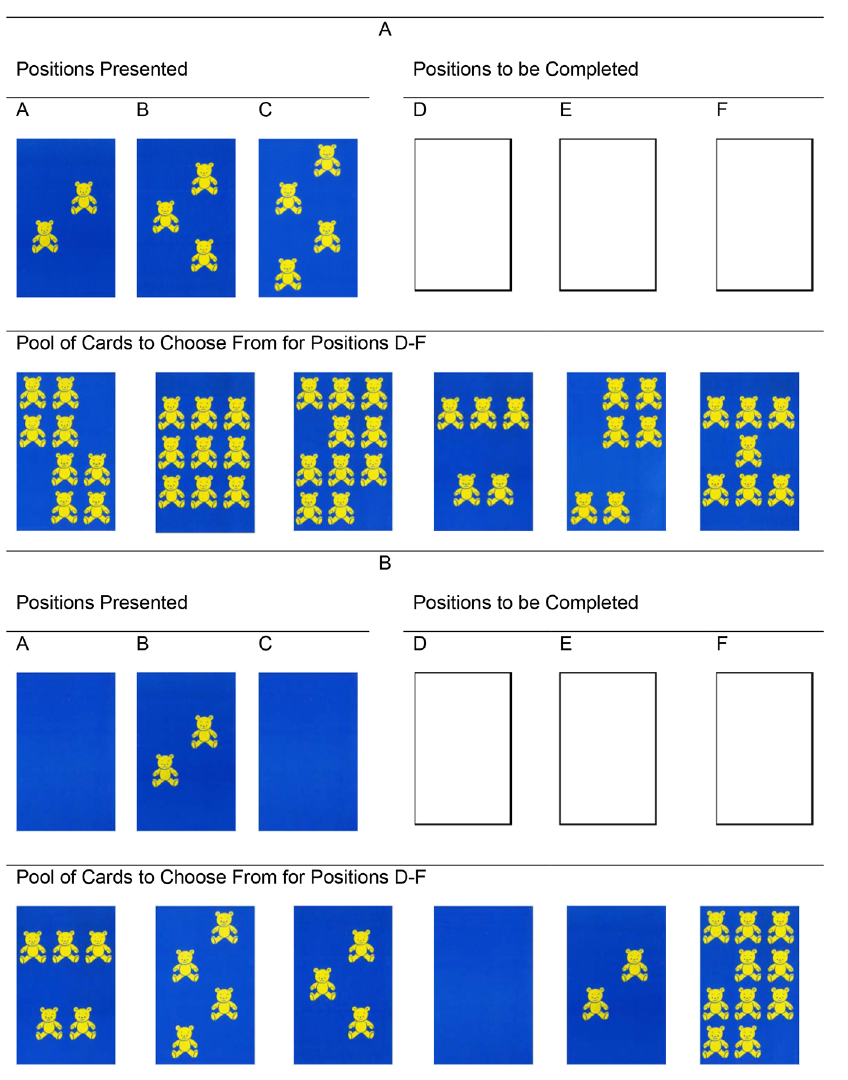
Figure 1. Two example trials (A represents Trial 1 and B Trial 4 of Table 1) of the Quantity Sequence Test (Guthke, 1983).